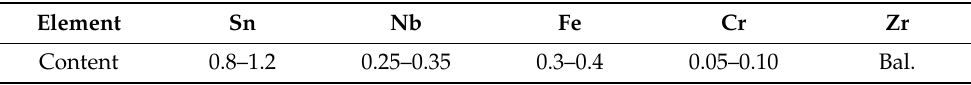
Table 1. Chemical composition of Zr-Sn-Nb alloy (wt%).